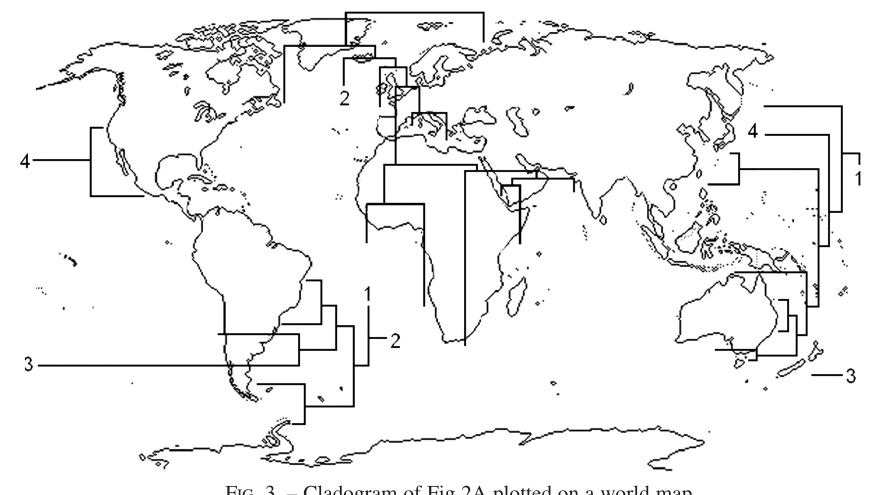
F IG . 3. – Cladogram of Fig 2A plotted on a world